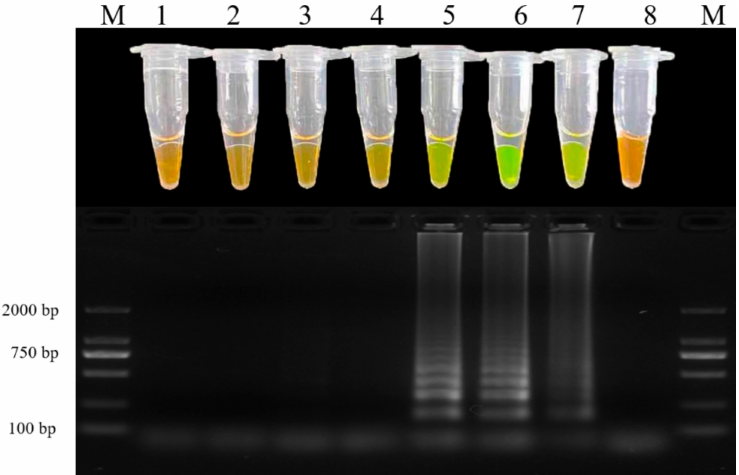
Figure 6. Profiles of LAMP reactions for P. graminea with different reaction times. Assessments of LAMP products based on SYBR Green I visualization of color change or agarose gel electrophoresis. Lane M, DNA ladder; tubes and lanes 1 to 7, LAMP reaction with reaction time of 10, 20, 30, 40, 50, 60, and 70 min, respectively; tube and lane 8, negative control with ddH 2 O for 60 min. After testing five factors affecting the LAMP reaction at different levels, the optimal LAMP conditions were determined using: a 25 µ L reaction volume containing 8.0 U of Bst DNA polymerase, 2.5 µ L of 10 × isothermal amplification buffer, 10 mM of MgSO 4 solution, 1.0 mM of dNTPs, 1.6 mM each of FIP and BIP, 0.4 mM each of F3 and B3, 0.2 mM of LB, 0.8 M of betaine, and 2.0 µ L of the target DNA template (10 pg to 100 ng), and the reaction mixture was incubated at 63 ◦ C for 60